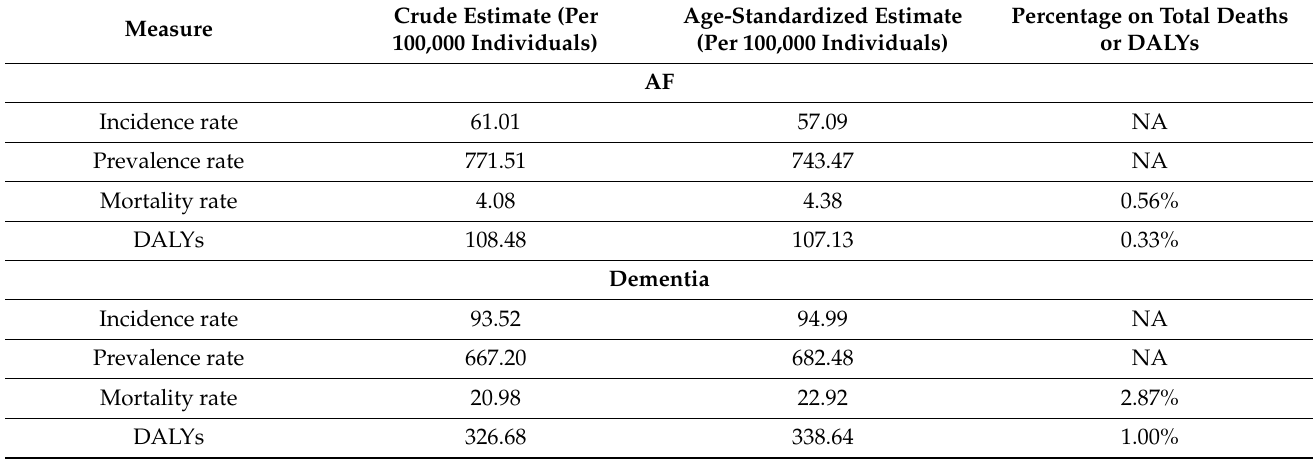
Table 1. Epidemiological metrics of atrial fibrillation and dementia in 2019 estimated by the GBD Study